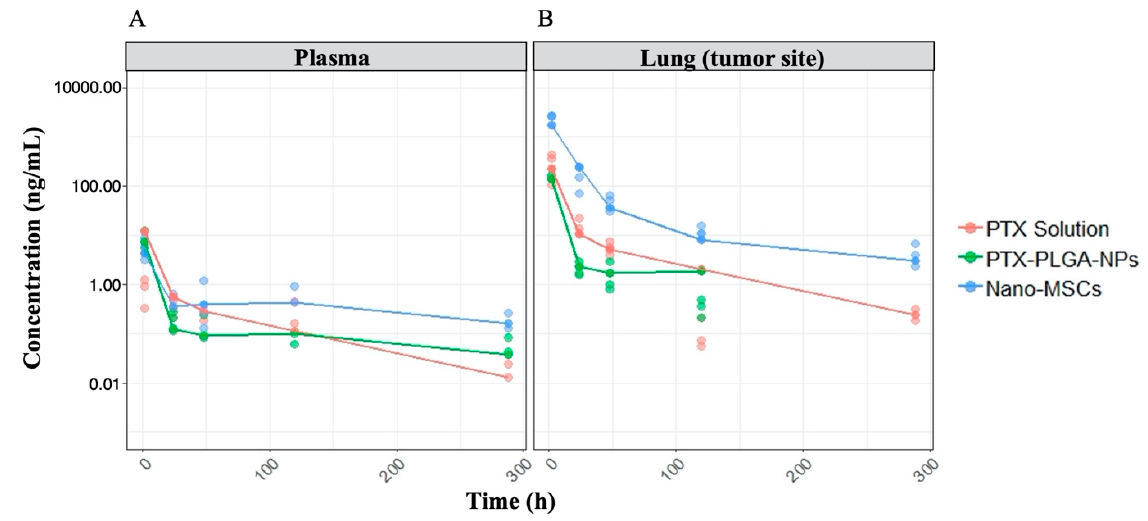
Figure 5. PK model fittings in plasma ( A ) and tumor-bearing lung ( B ). The plots are on log scales. The dots represent PK observations (red: PTX Solution; green: PTX-PLGA NPs; blue: nano-MSCs). The lines represent PK models predicted PK profiles (red: PTX Solution; green: PTX-PLGA NPs; blue: nano-MSCs).